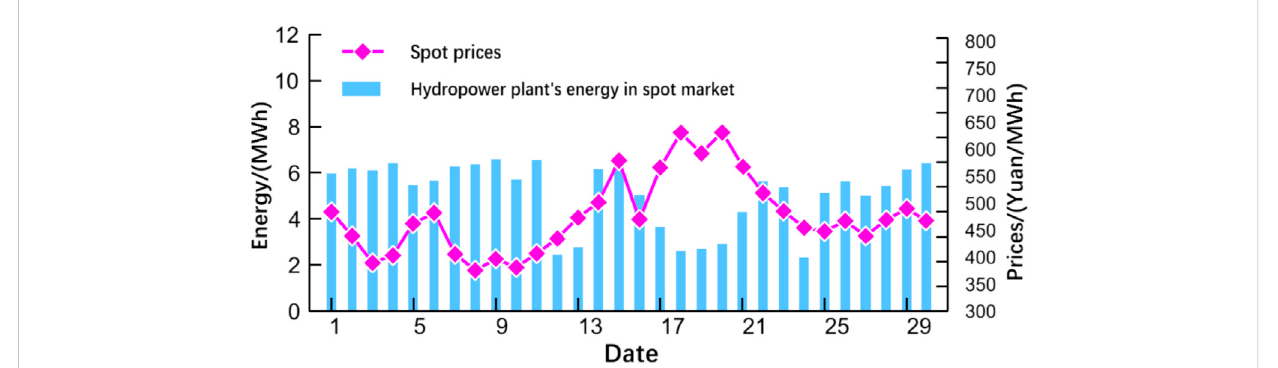
FIGURE 4 The matching analysis result of the hydropower plant ’ s energy in the spot market and the spot price.